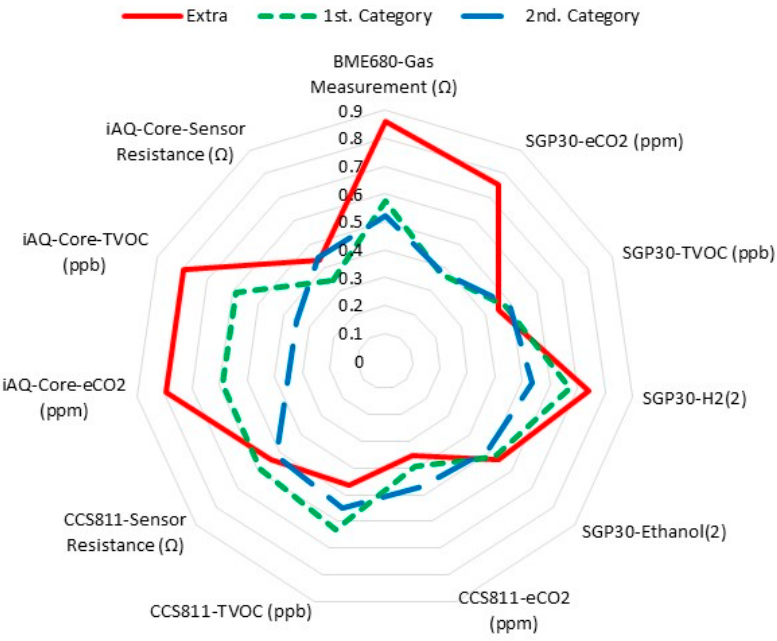
Figure 3. Radial plots of the sensor’s responses to Spanish-style table olives of different categories.